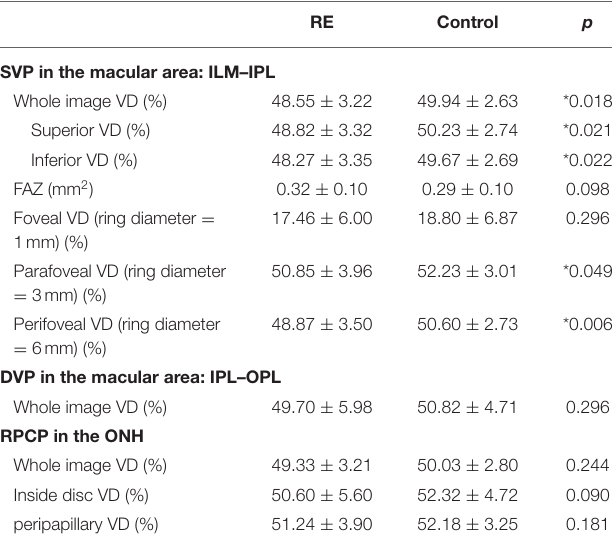
TABLE 2 | Major vessel measurements in OCTA between RE and controls. RE Control p